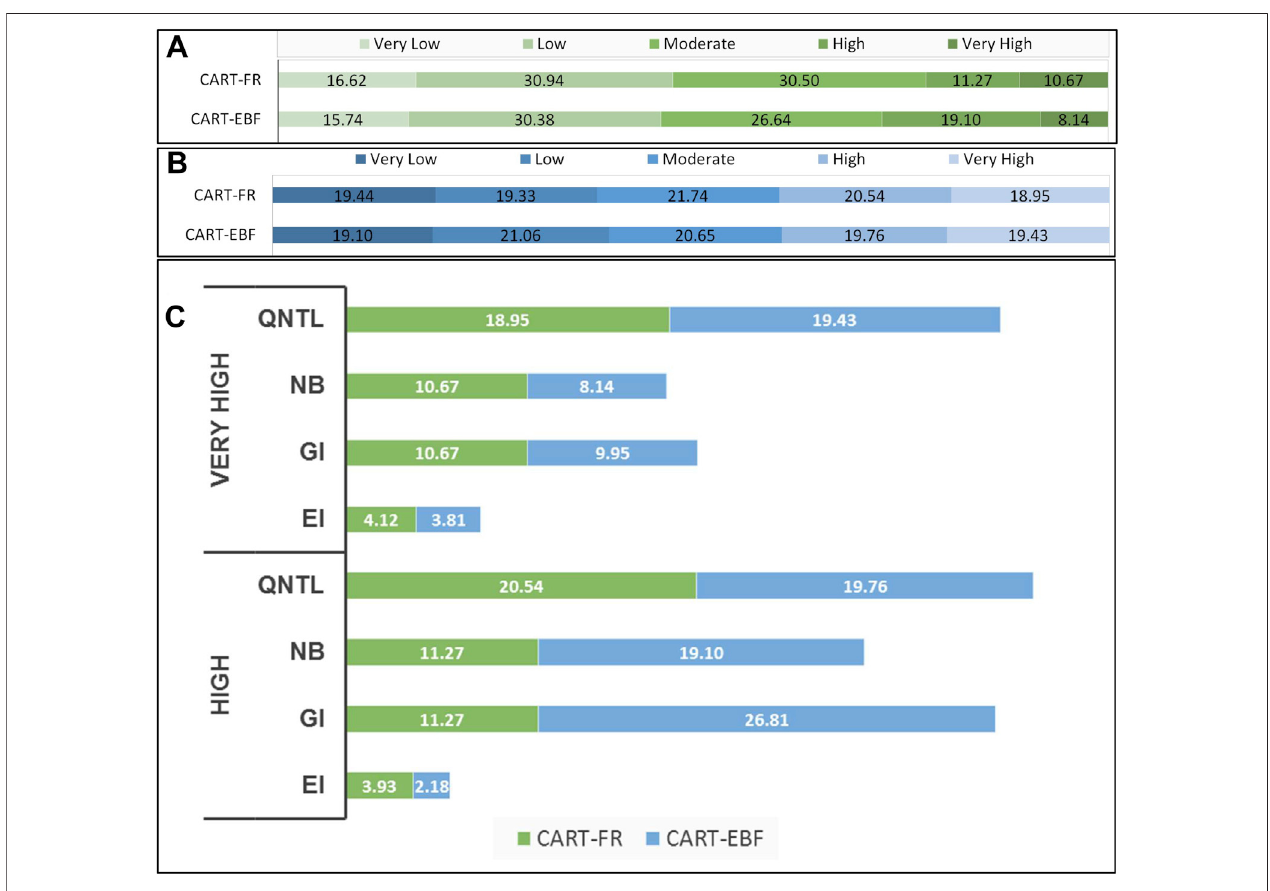
FIGURE 6 | FSPI histogram classi fi cation of both models ’ outputs. In parts (A) and (B) , Percentage share of areal coverage in “ very low, ” “ low, ” “ medium, ” “ high, ” and “ veryhigh ” categories asclassi fi ed byNaturalBreak (NB) and Quantile (QNTL) methods, respectively, isvisualized,whereas, inpart (C) ,areal coverage (%)byusing four methods (EI-Equal Interval; GI-Geometric Interval; NB-Natural break; and QNTL-quantile) for only “ high ” and “ very high ” classes is demonstrated.